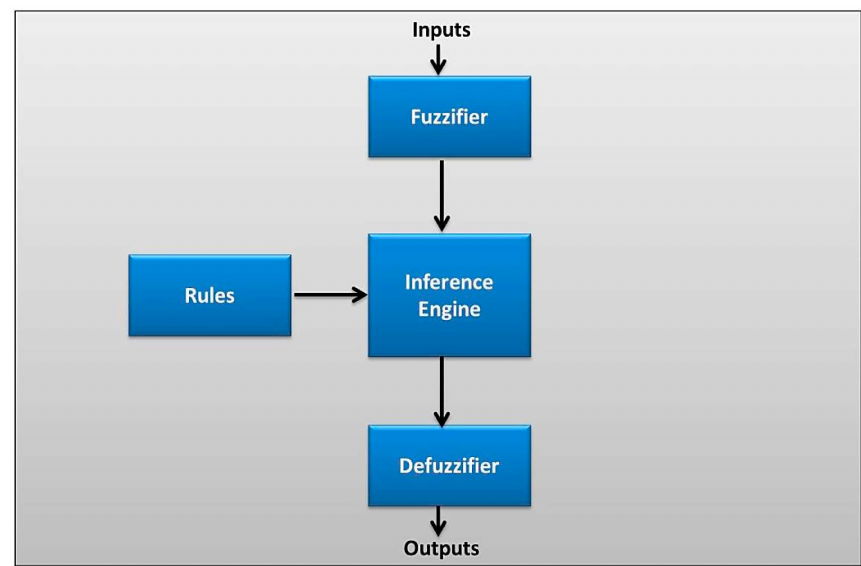
Figure 2. Block diagram of the Fuzzy Logic System.